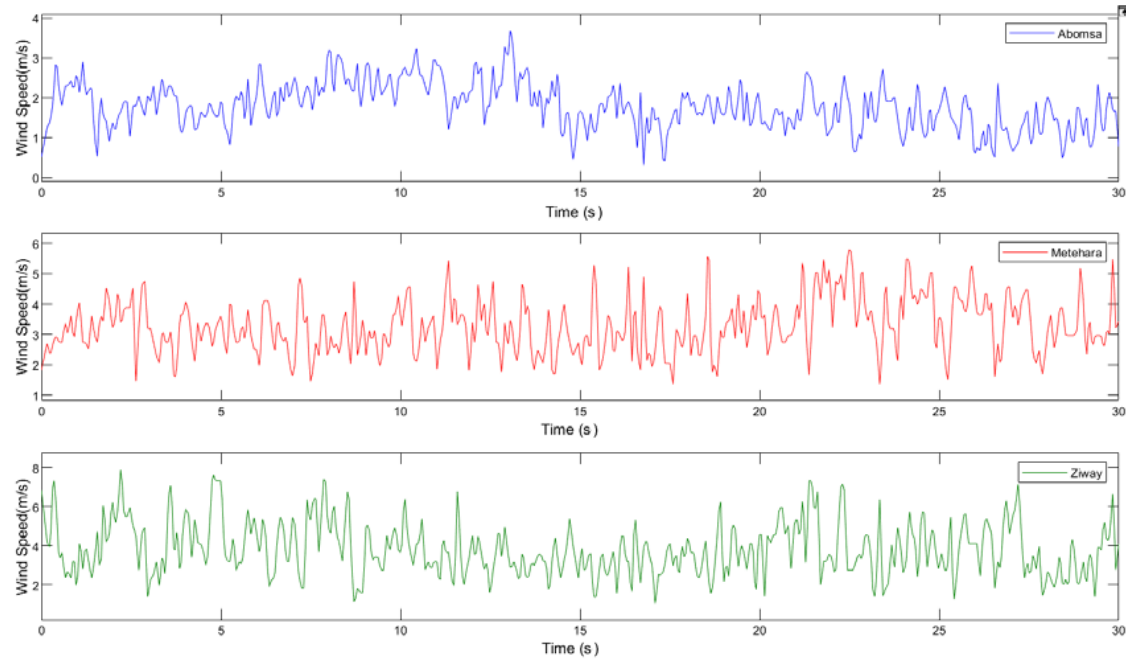
Figure 14. Wind speed profiles of three selected sites.